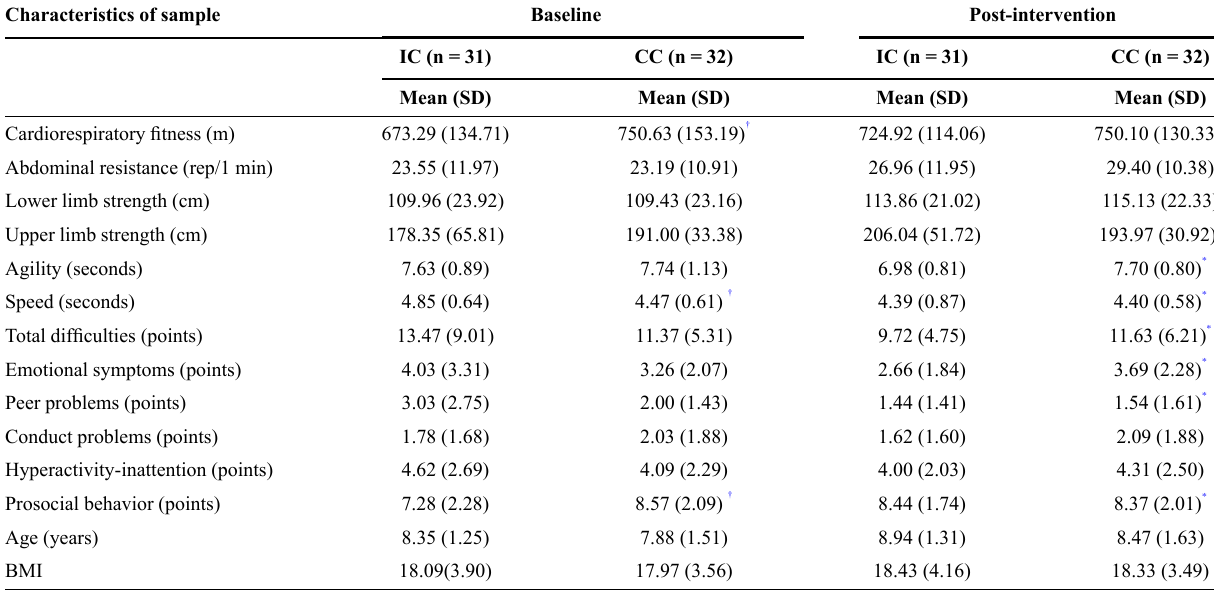
Table 1 - Descriptive characteristics of sample at baseline and post-intervention programs of physical education, according to intervention and control condition. Characteristics of sample